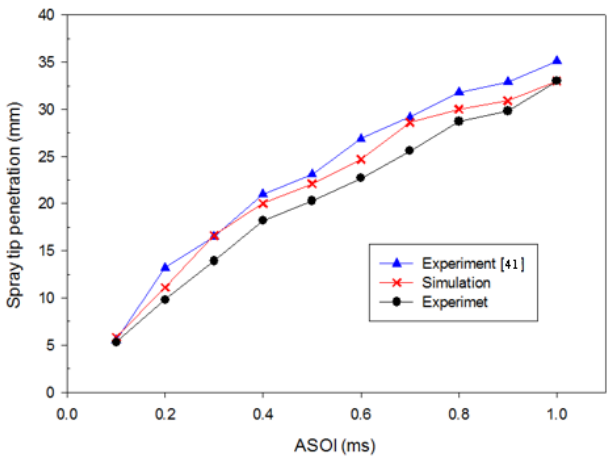
Figure 10. Spray tip penetration growth for a circular nozzle shape with 50 MPa of pressure and 3 MPa of backpressure for the experiments and simulation.